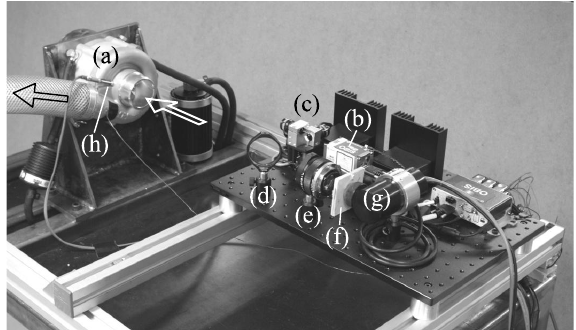
Figure 4. Photograph of the experimental setup with ( a ) compressor; ( b ) diode laser; ( c ) scanning galvanic mirrors; ( d ) dichroic mirror; ( e ) lens; ( f ) long-pass filter; ( g ) photo-multiplier tube; and ( h ) blade passage sensor.